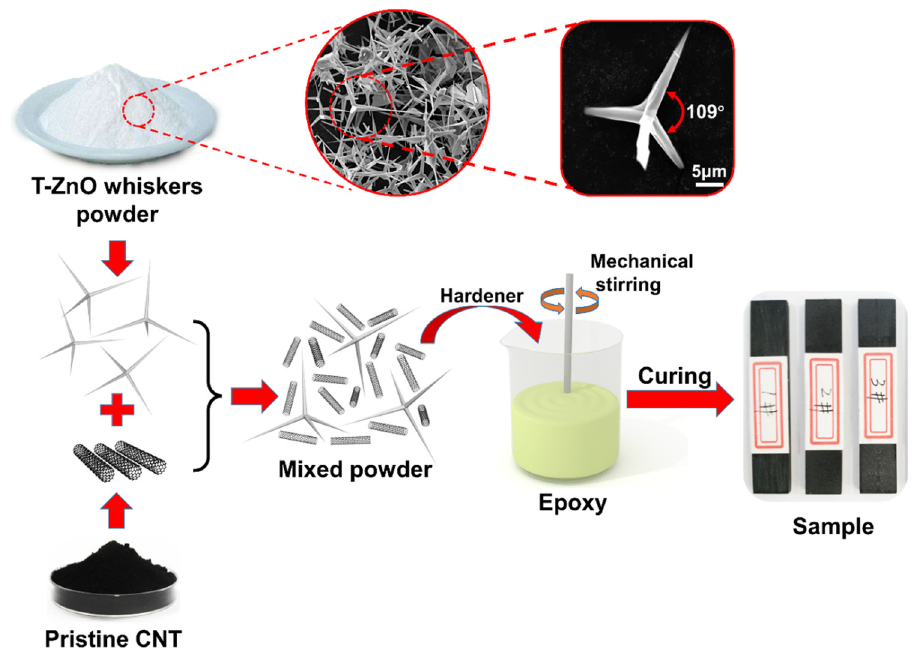
Figure 1: Structure of T - ZnO and schematic of the fabrication procedure of CNTs/T - ZnO/epoxy